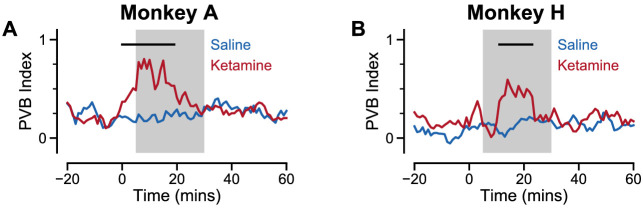
Time course of ketamine’s influence on pro-variance bias.(A) The time course of the pro-variance bias index (PVB) is shown for Monkey A. The PVB index is significantly raised for around 20 min following ketamine administration (red). The black horizontal bar at the top of the graph denotes a significant difference between saline (blue) and ketamine conditions at the respective time points (cluster-based permutation test, p=0.0080; see Materials and methods). (B) As in (A), except for Monkey H (cluster-based permutation test, p=0.0332).